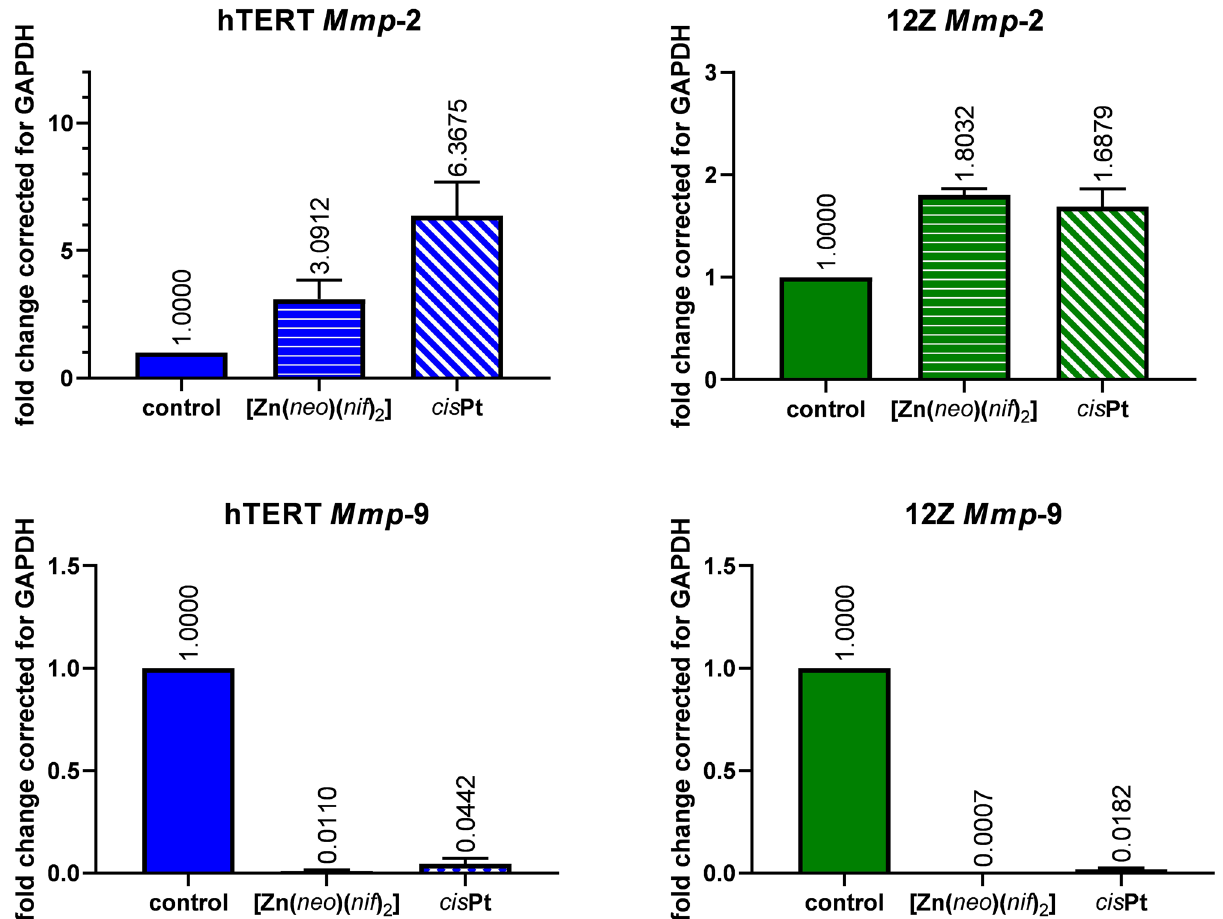
Figure 7. The relative gene expression of Mmp-2/9 in control (untreated cells hTERT or 12Z), cells treated with 10 µM [Zn( neo )( nif ) 2 ] or 10 µM cisPt for 24